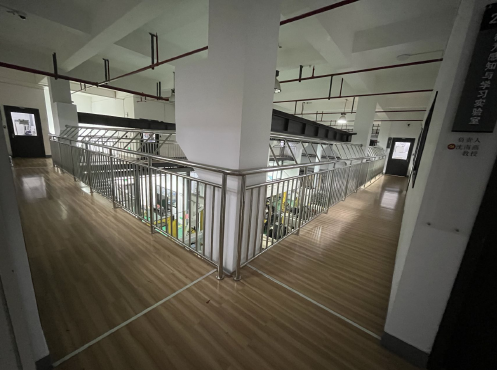
Figure 6. The scene of the corridor